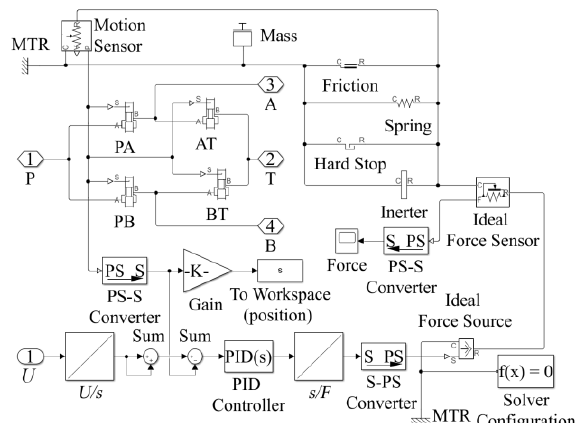
Fig. 6. Subsystem of proportional directional